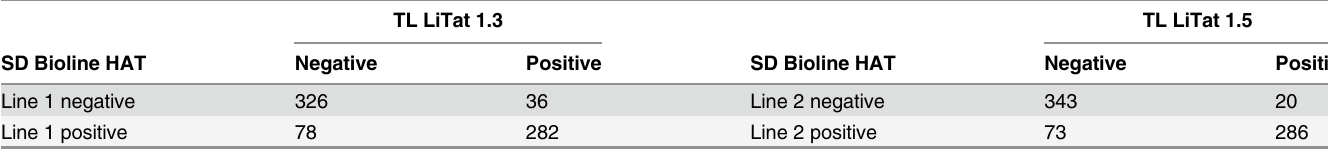
Table 3. Reactivity of individual test lines in SD Bioline HAT in function of trypanolysis results of the corresponding T.b. gambiense variable antigen type. TL LiTat